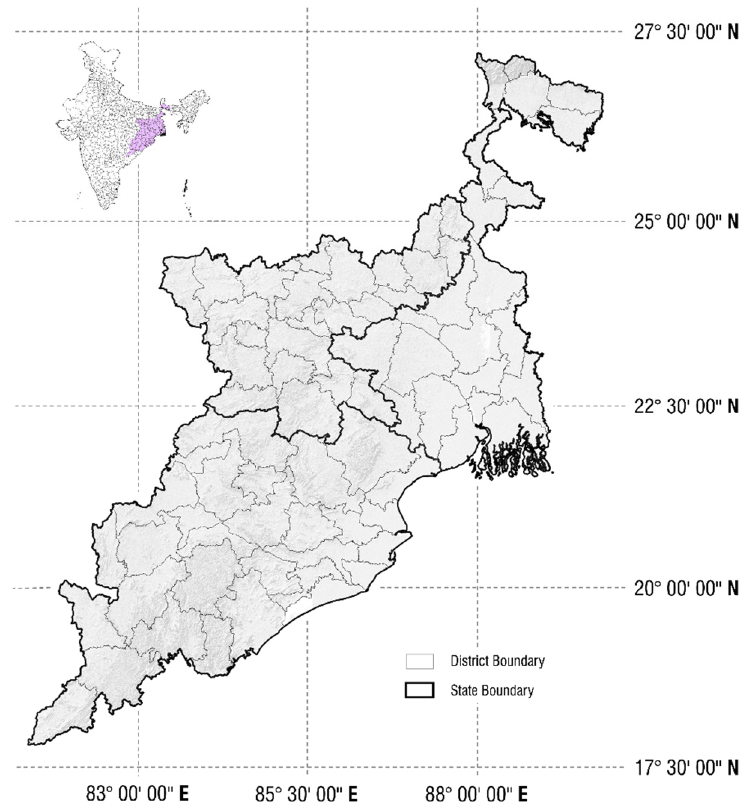
Figure 1. Study area of Eastern India which covers Odisha, Jharkhand and West Bengal.